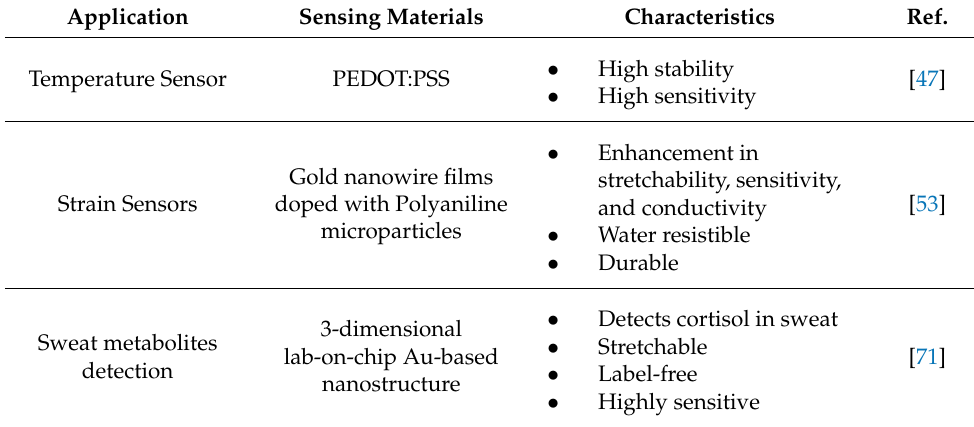
Table 3. Recent advances in sensing materials in healthcare